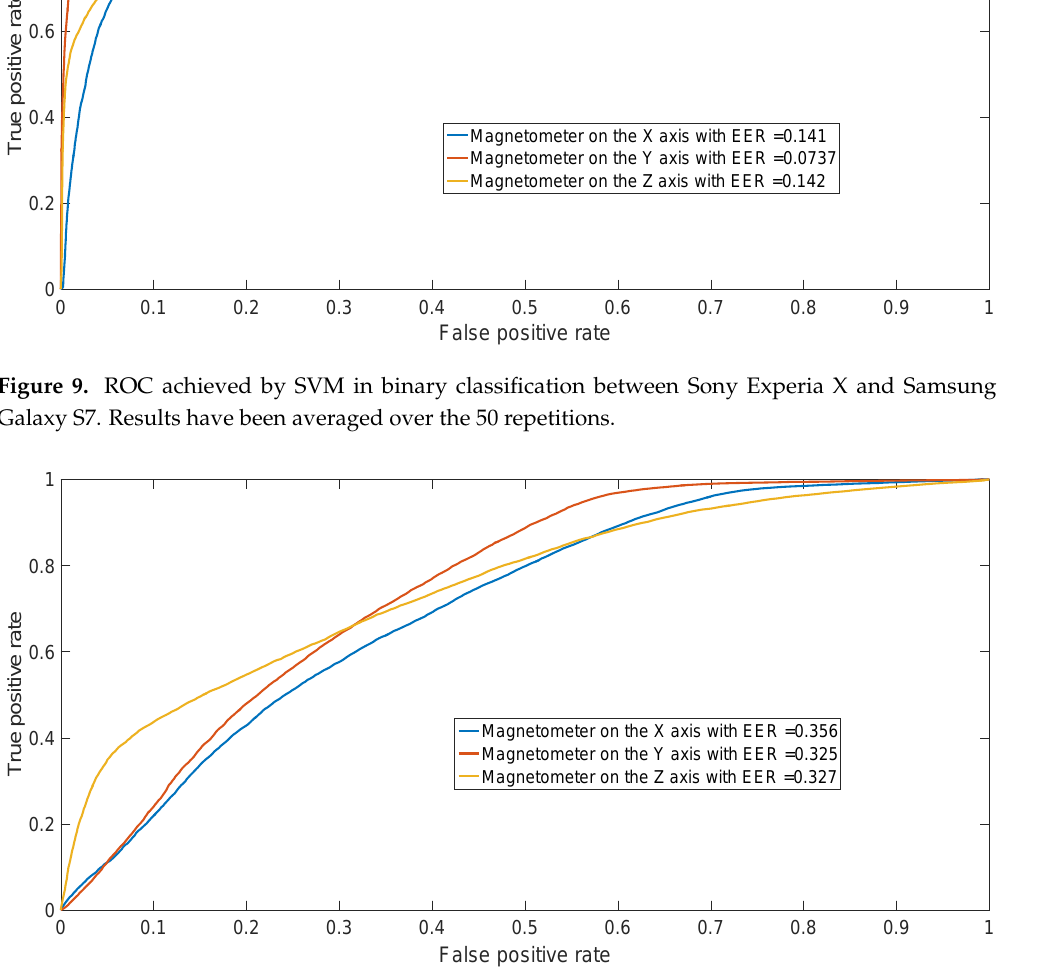
Figure 10. ROC achieved by SVM in binary classification between HTC One X 2 and HTC One X 3. Results have been averaged over the 50